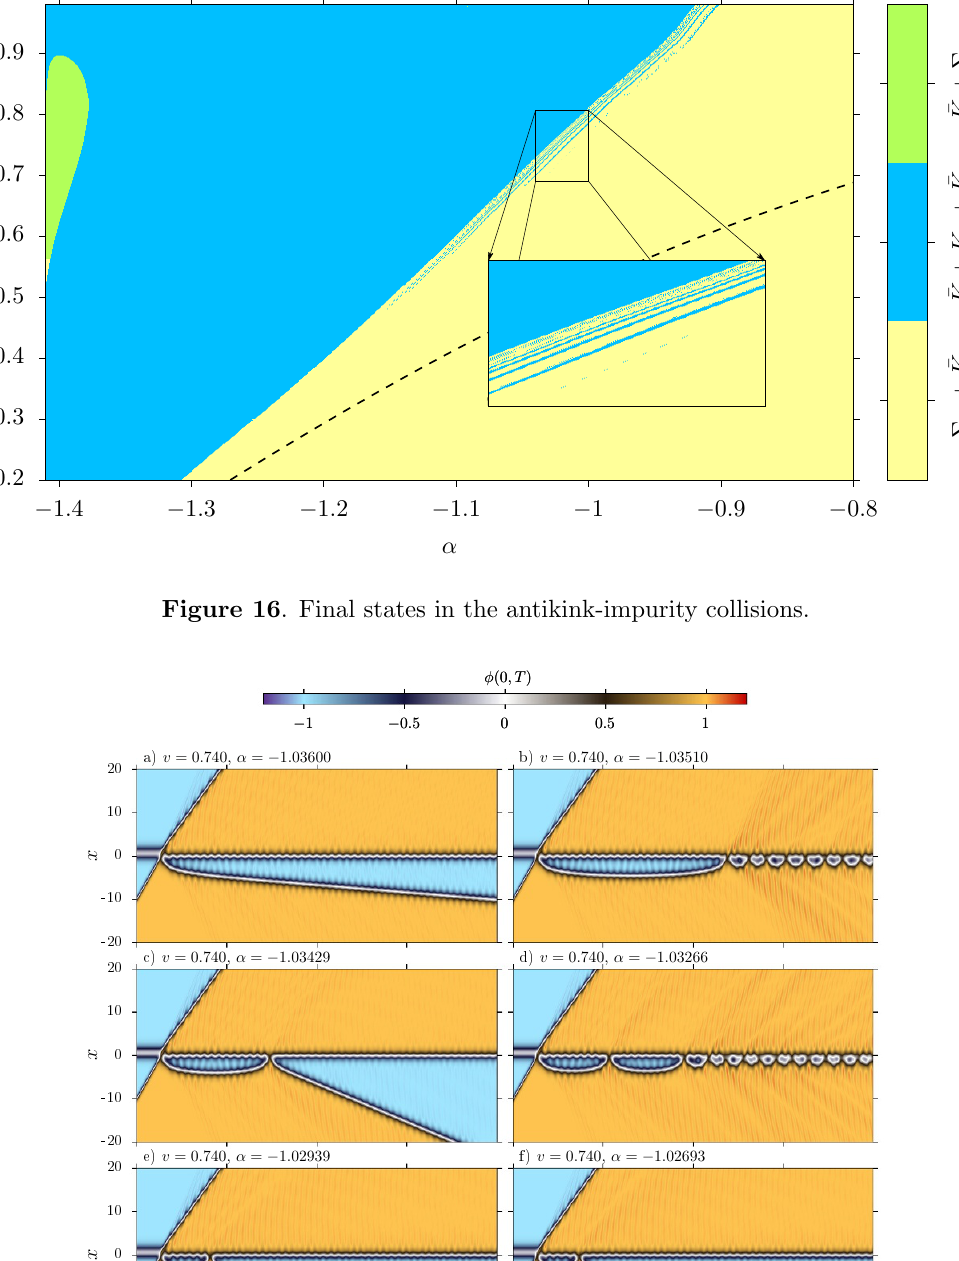
time t time t Figure 17 . Chaotic behaviour of antikink-impurity ( (cid:22) K +(cid:6) (cid:0) ) collisions with multibounce windows for initial velocity v = 0 : 74. The parameter values for the di(cid:11)erent plots are a) (cid:11) = (cid:0) 1 : 03600, b) (cid:11) = (cid:0) 1 : 03510, c) (cid:11) = (cid:0) 1 : 03429, d) (cid:11) = (cid:0) 1 : 03266, e) (cid:11) = (cid:0) 1 : 02939 and f) (cid:11) = (cid:0) 1 : 02693.